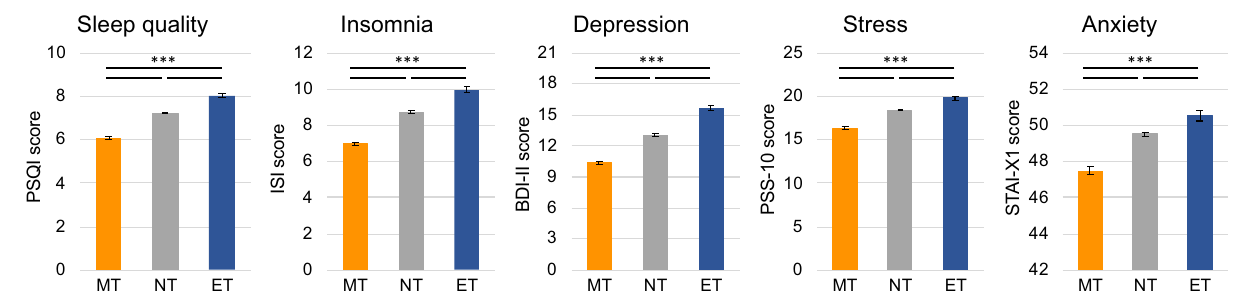
Figure 1. Sleep quality (PSQI), insomnia severity symptoms (ISI), depression (BDI-II), perceived stress (PSS- 10), and anxiety (STAI-X1) for the three chronotype groups (Morning-type—MT, Neither-type—NT, Evening- type—ET). Means (and standard errors) of questionnaire scores are reported. Results of Bonferroni post hoc comparisons are reported with asterisks (*** p <